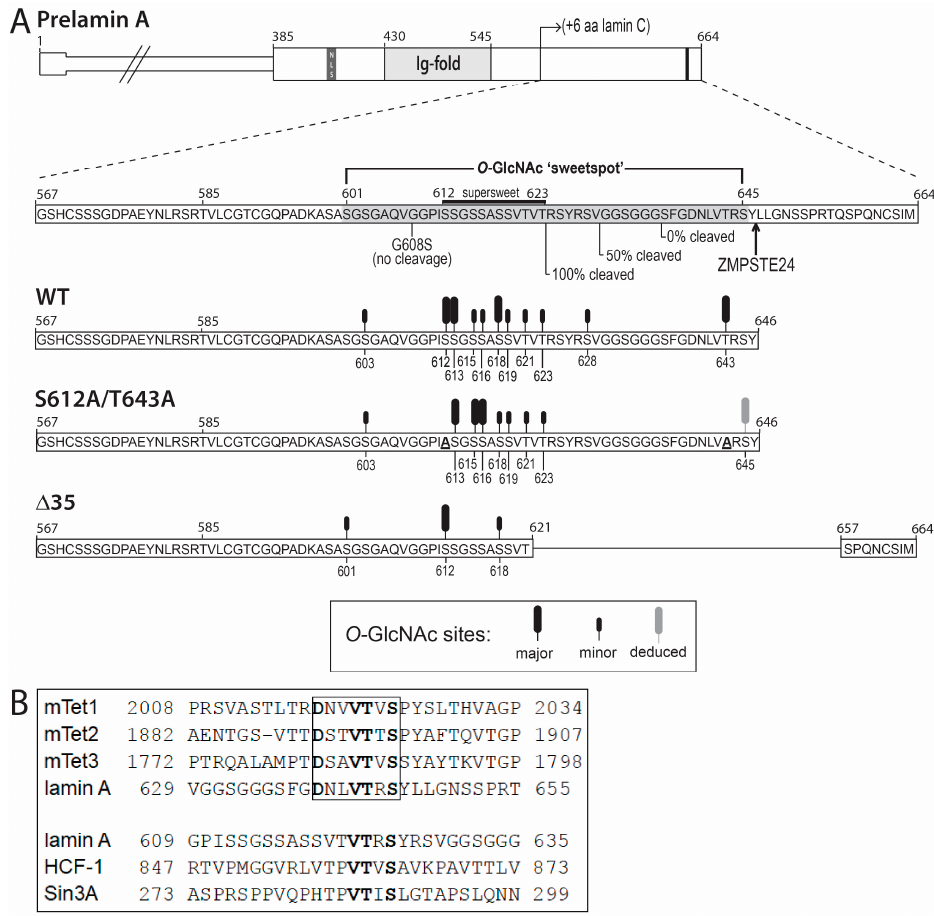
Figure 6. Schematic of lamin A tail polypeptides showing identified O -GlcNAc sites. ( A ) Schematic diagram of full-length prelamin A and the three recombinant lamin A tail fragments (wildtype—WT, S612A/T643A, Δ 35) analyzed by mass spectrometry, all of which started with residue 385. All identified O -GlcNAc sites are located in the C-terminal region unique to prelamin A, expanded below (dotted lines) to show the amino acid sequence. Abundant or less-abundant O -GlcNAc sites are symbolized by large (‘major’) or small (‘minor’) black rods, respectively. The ZMPSTE24-dependent proteolytic cleavage site is indicated. The starting points of fragments that were cleaved by ZMPSTE24 with 100%, ~50%, or 0% efficiency in cells [41] are indicated below the sequence. Mutation G608S is sufficient to block cleavage in a different assay [42]. The region targeted by OGT in both wildtype and mutated lamin A tails (residues 601–645) is broadly designated the ‘sweet spot’, and includes ‘supersweet’ residues 612–623 ( O -GlcNAc detected at every Ser and Thr); ( B ) amino acid sequence of the OGT-binding region in mouse Tet1 compared to homologous regions of conspecific Tet2 and Tet3 [43], two regions in human lamin A, and human HCF-1 and Sin3A. Bold residues are important for mTet1 binding to OGT [43]. Box indicates best conservation between mTet proteins and human lamin A residues 639–645. Human protein sequences were aligned against the consensus sequence found in mouse Tet1 using EMBOSS water pairwise alignment tool v.6.6.0 under default conditions for short sequence alignments (gap penalty: 10.0, extend penalty: 0.5). The upstream VT X S motif in lamin A (residues 609–635) was aligned manually against HCF-1 and